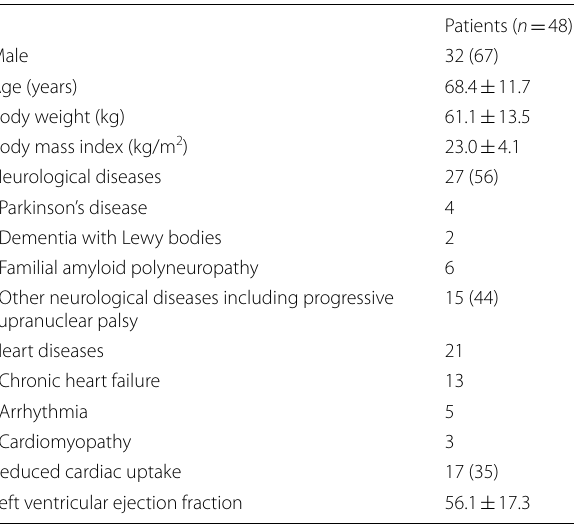
Data are shown as n , n (%), means